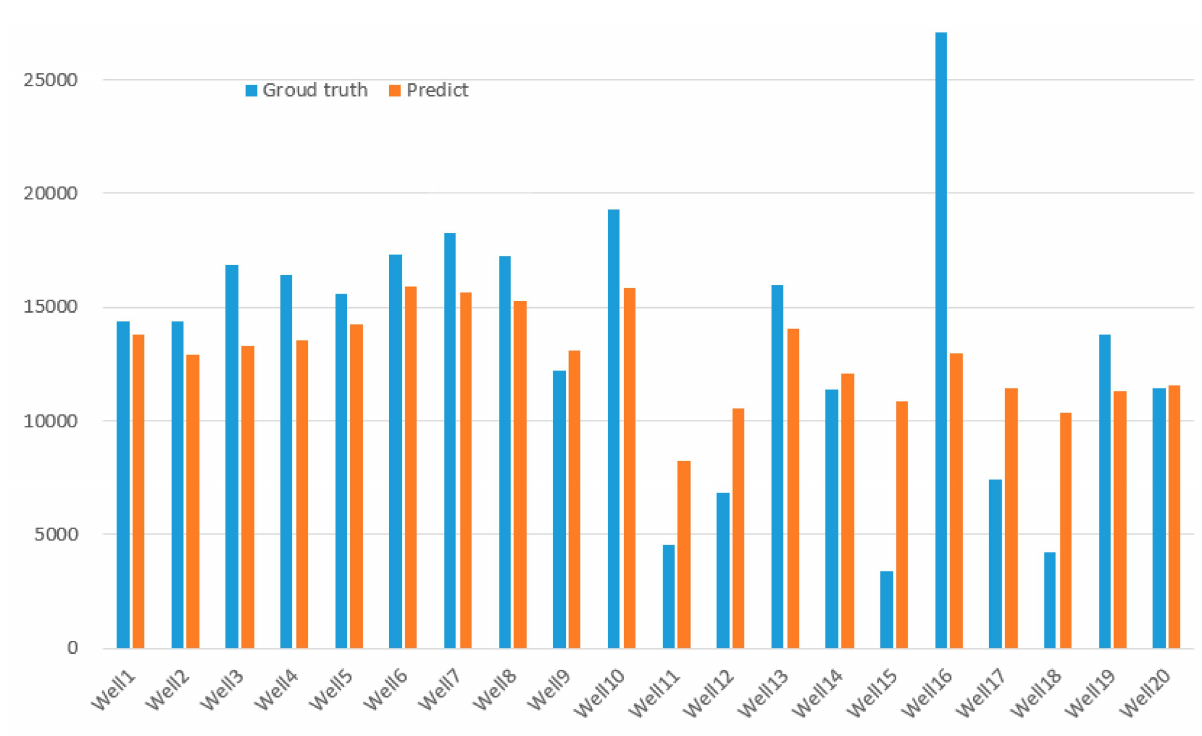
Figure 6. Horizontal Shale Gas Well Capacity Prediction vs. Ground